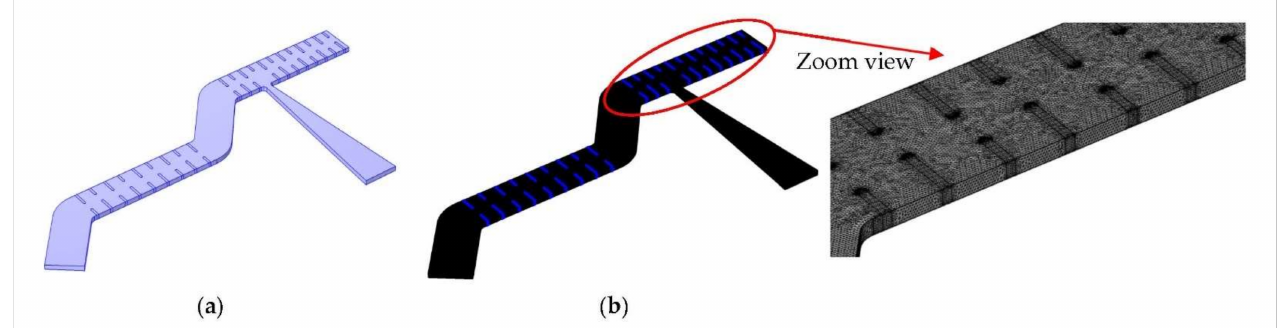
Figure 7. Cilia microchip: ( a ) Computational domain; ( b ) Computational domain meshing.